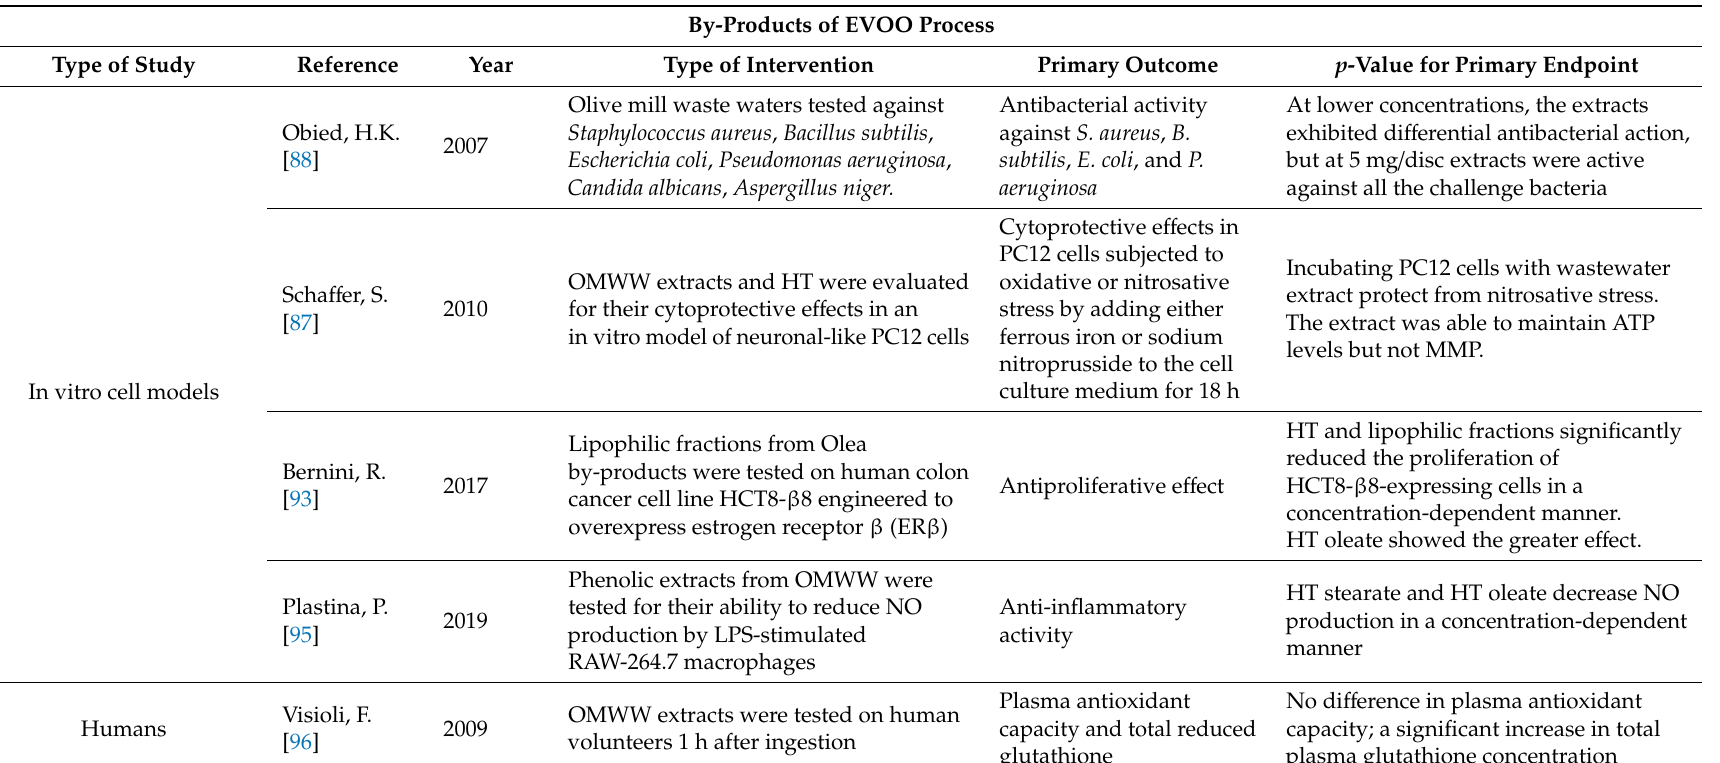
Table 3. Biological activity of Olea europaea L.